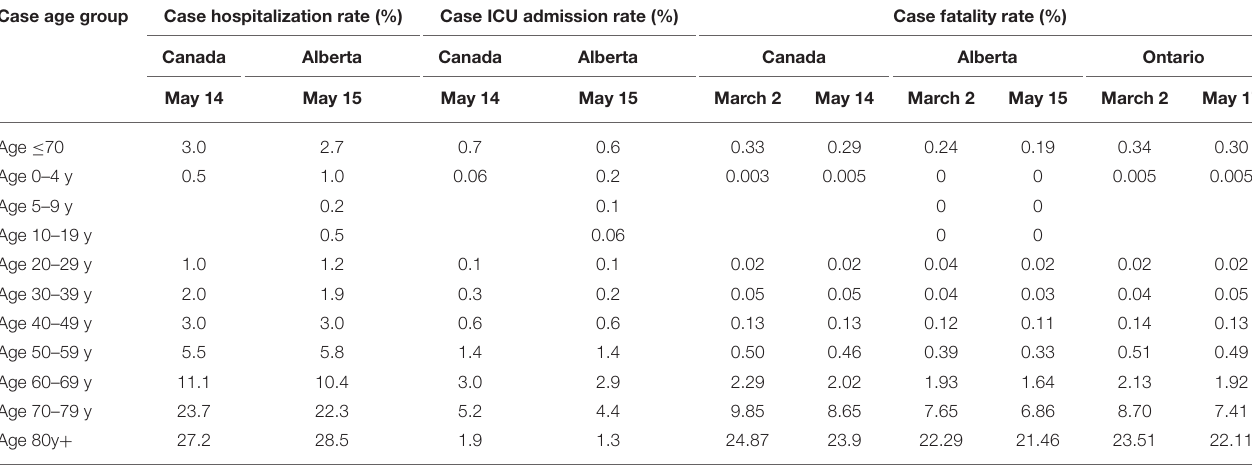
TABLE 2 | Case hospitalization, intensive care unit, and fatality rate for SARS-CoV-2 in Canada and selected Provinces as of mid-May, 2021 a . Case age